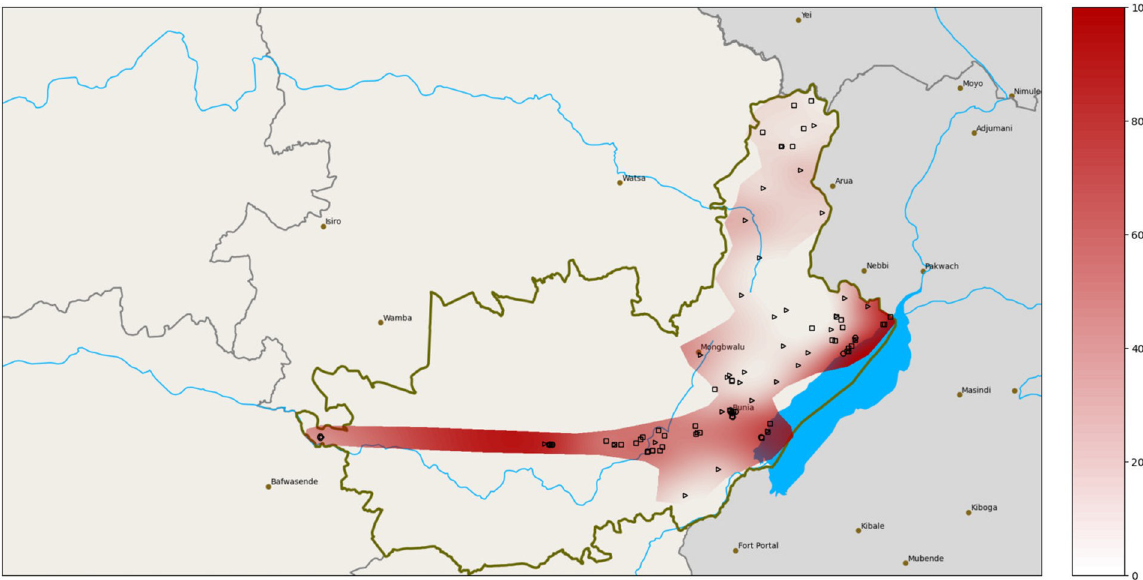
Fig 5. Map of Ituri province with estimated S . mansoni prevalence. Predicted S . mansoni prevalence using non–uniform spline interpolation. Intensity of red shadows is proportional to prevalence levels (y-axis). Dots indicate studied villages. Areas outside of the red shadow were inaccessible, dense tropical forest and sparsely populated. Map created by Oleksii Morozov based on geo data from https://data.humdata.org/ dataset/f42132b9-8cc6-4201-b020-9259c56e8868/resource/e335bc0b-b946-437f-b771-beb5599eaf1d/download/cod_admbnda_rgc_itos_ 20190911_shp.zip and https://www.naturalearthdata.com.